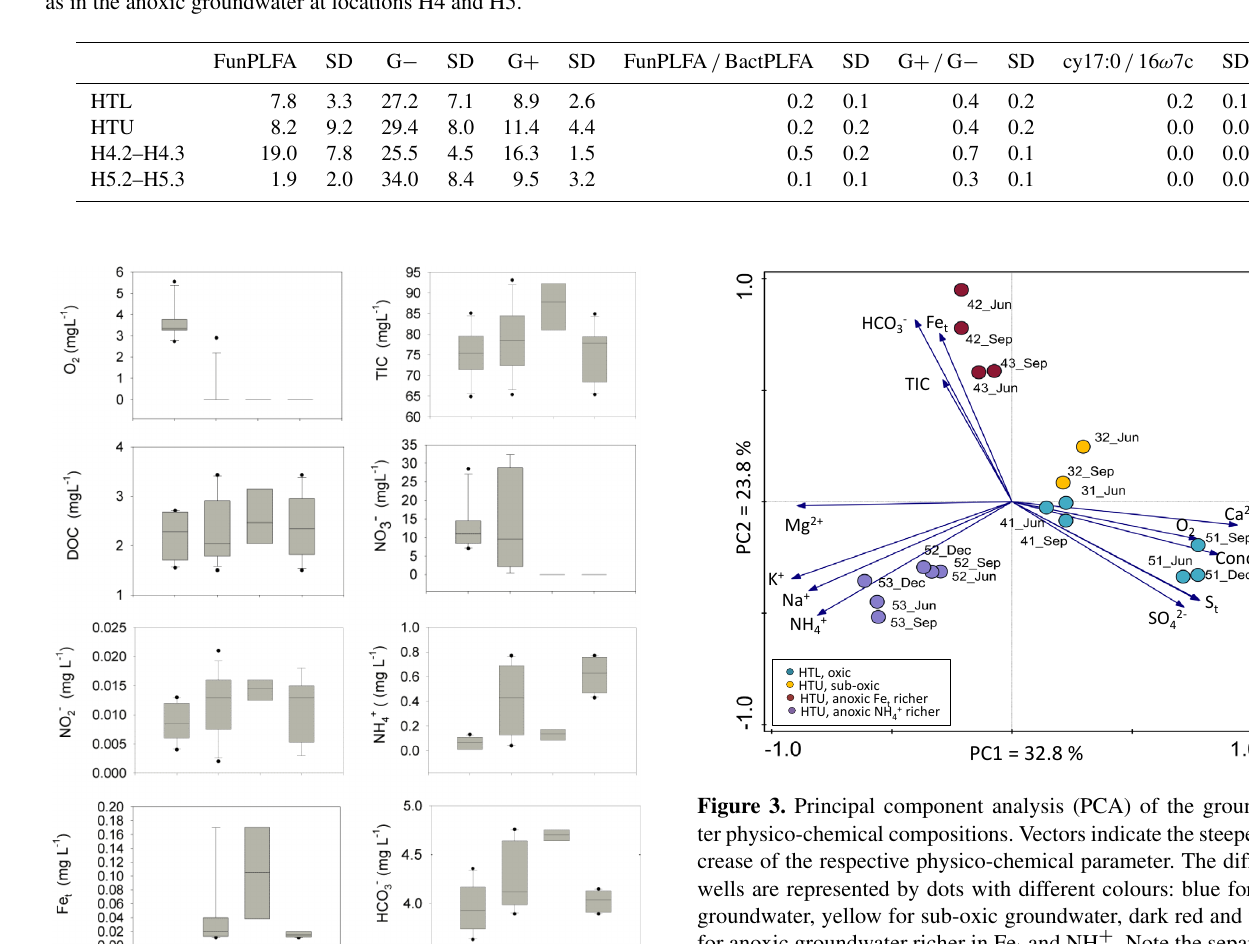
0.8 ± 0.7 %), derived from Deltaproteobacteria mainly en-